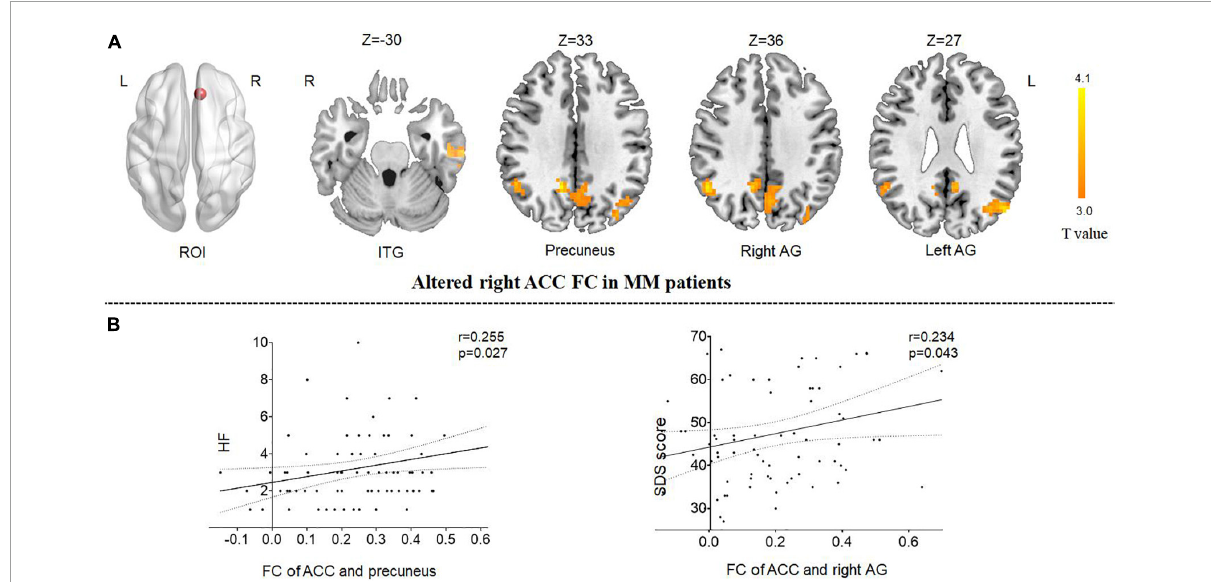
FIGURE2 Functional analysis results of the right ACC in the resting state in patients with MM compared with HCs ( P < 0.05, Gaussian random field-corrected). (A) Patients with MM showed increased FC between the right ACC and the left ITG, the right precuneus, and the bilateral AG as compared to HCs. (B) The FC changes in the right ACC, right precuneus, and right angular gyrus were positively correlated with clinical indicators ( P -uncorrected). ACC, anterior cingulum cortex; AG, angular gyrus; FC, functional connectivity; HF, headache frequency; ROI, regions of interest; ITG, inferior temporal gyrus; HC, healthy control; MM, menstrual migraine